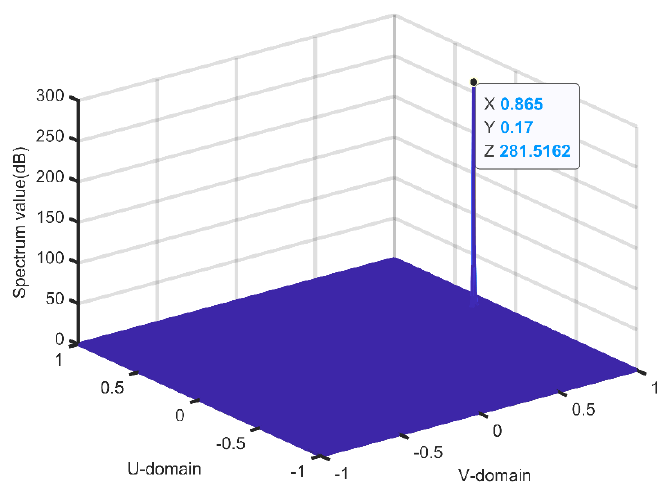
Figure 6. Spatial spectrum of the traditional MUSIC algorithm.